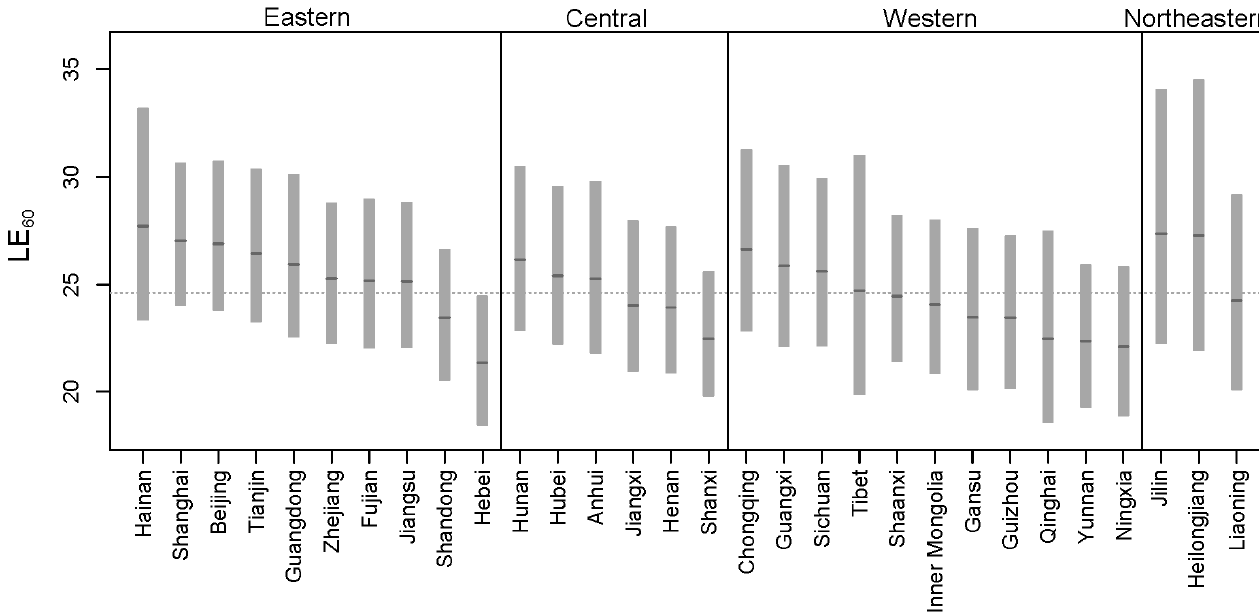
i C LE of Chinese provinces in 2030. Figure 10. LE i , C of Chinese provinces in 60 60